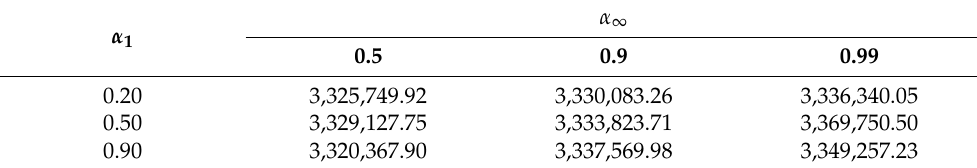
Table 18. Comparison of the results at different confidence